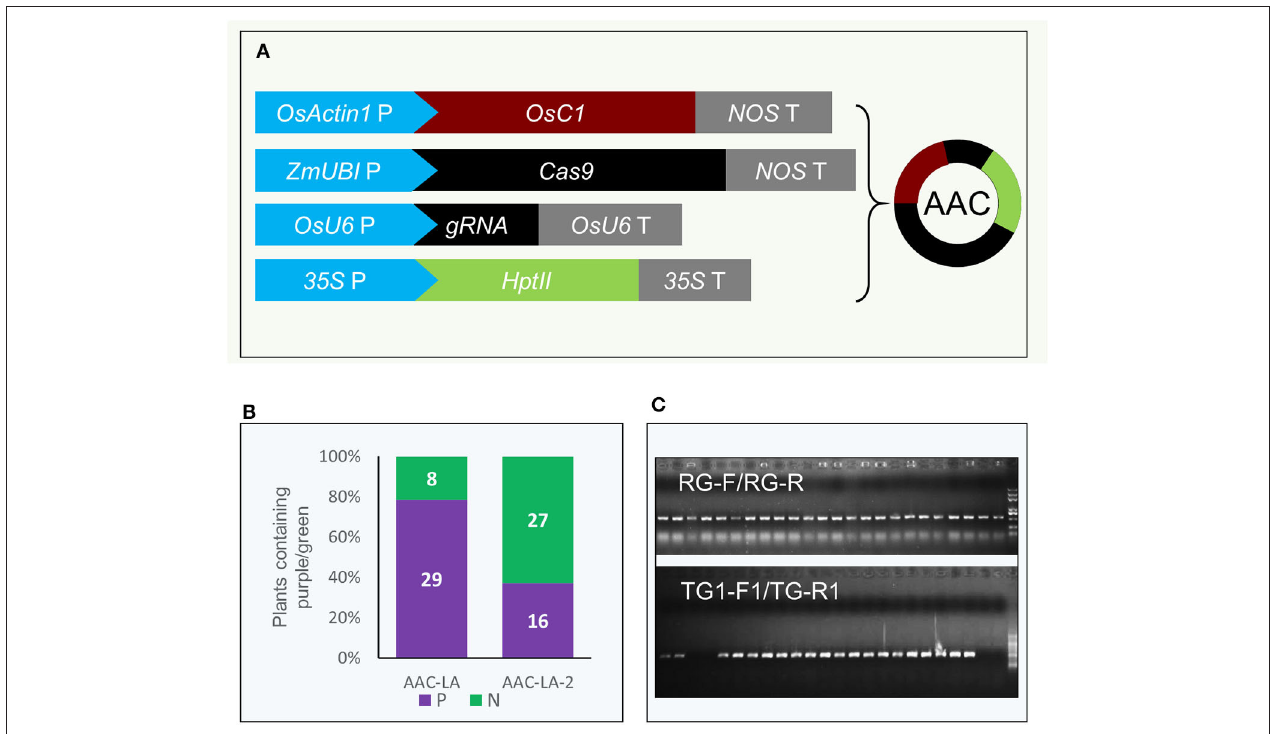
FIGURE 2 | Anthocyanin accumulation as a marker for the presence of transgenes in gene editing experiments. (A) Coupling the pACTIN-OsC1 unit with the CRISPR/Cas9 genome editing units in the AAC (Anthocyanin-marker Assisted CRISPR) plasmid. The anthocyanin regulatory gene OsC1 is under the control of the rice OsACTIN1 promoter. NOS T refers to the terminator of the nopaline synthase gene from Agrobacterium tumefaciens . The rice codon-optimized Cas9 was placed under the control of the maize UBIQUITIN promoter. OsU6 P and OsU6 T represent rice U6 promoter and terminator, respectively. gRNA refers to guide RNA. The transcription of hygromycin phosphotransferase II gene HptII is under the control of the CaMV 35S promoter and the transcription was terminated with a CaMV 35S terminator. (B) Not all antibiotic resistant plants generated purple color in T0. AAC-LA was transgenic event screening from the plate with two rounds hygromycin selection (10 days in a round). AAC-LA-2 was regenerated from the calli on normal plate after 7 days hygromycin selection (only one round). “P” and “N” represent purple and normal color plants, respectively. (C) Verification of the transgenes in the rice plants by PCR. “RG-F/RG-R” and “TG-F1/TG-R1” refer to the primer pairs used for detection the presence of rice genomic DNA and the T-DNA of AAC plasmid, respectively. The primer information was described in Supplementary Table 3